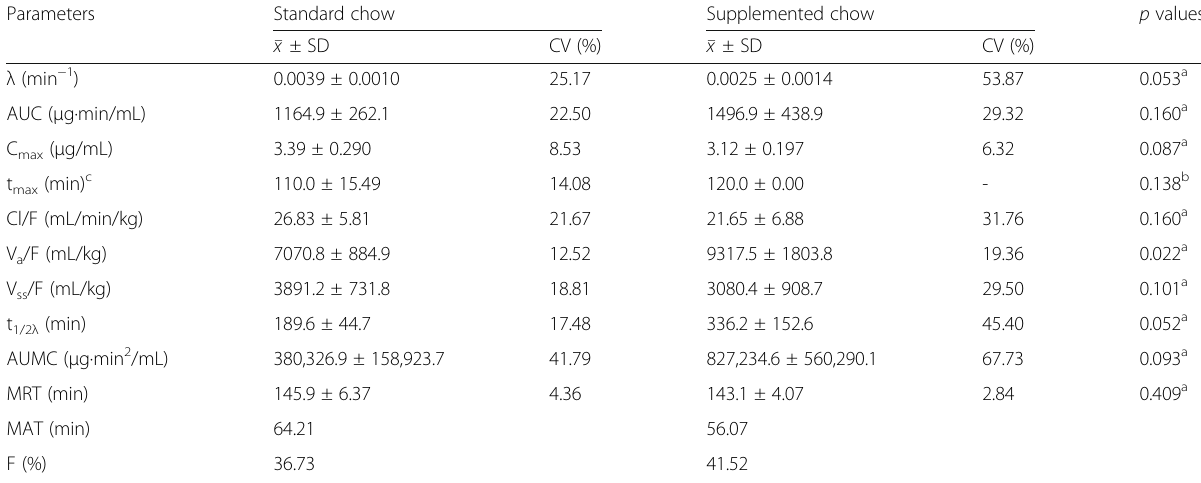
Table 5 Non-compartmental pharmacokinetic parameters obtained for metformin (30 mg/kg) after its oral administration with Plantago ovata husk (300 mg/kg) to diabetic rabbits ( n = 6)